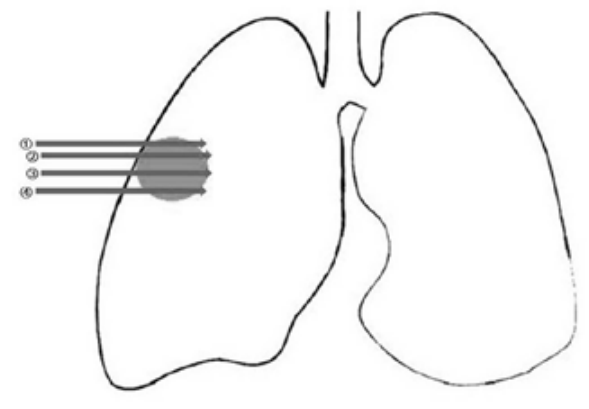
Figure 6 The model of the ablation plan with four ablation sites